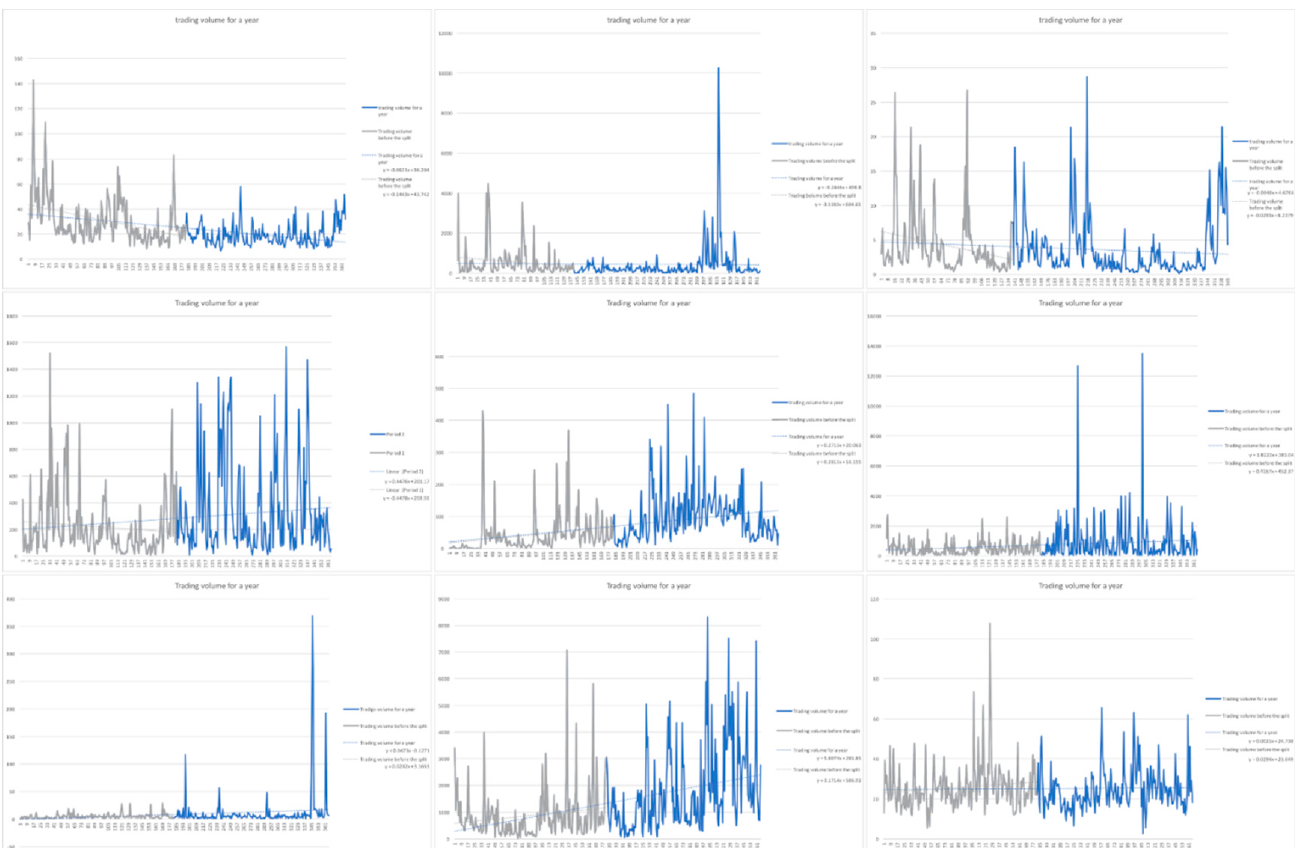
Figure 16. Trading volume half a year before and after the split day. The blue line represents the trading volume half a year after the split day, and the grey line represents the trading volume half a year before the split.